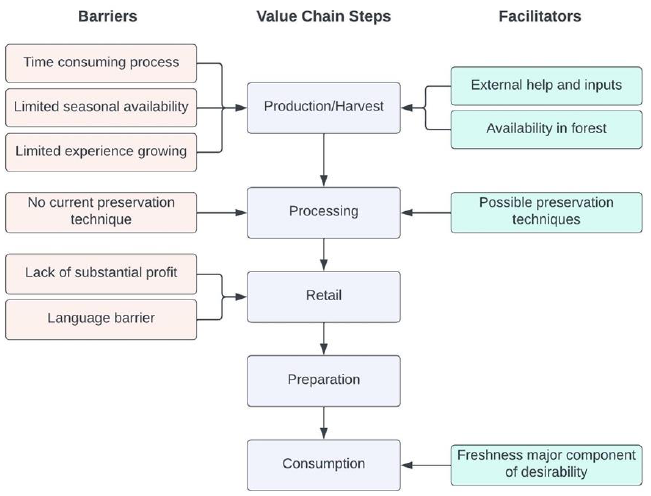
Figure 6. Overview of barriers and facilitators to the production and consumption of Koinaar